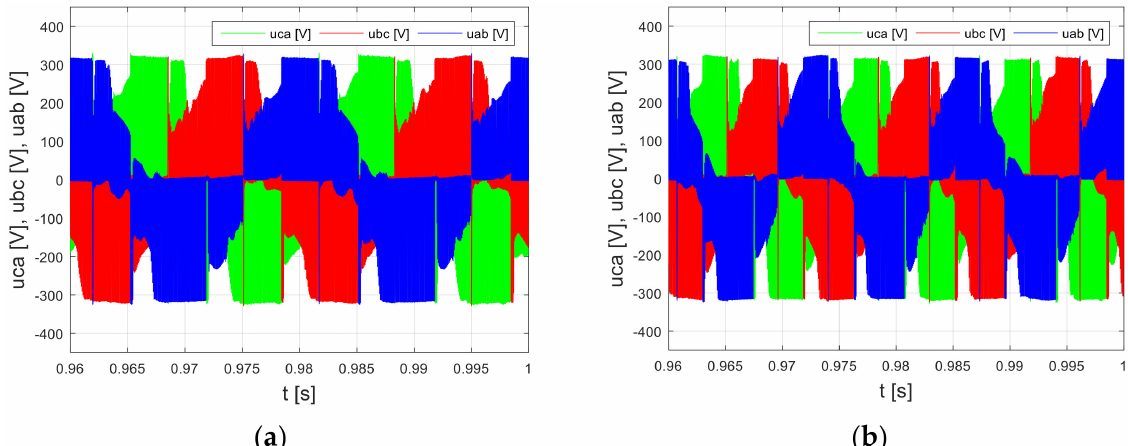
Figure 11. Waveforms of the line-to-line voltages (uab, ubc, uca) at 60 bar pressure for the speed of: ( a ) 1000 rpm; ( b ) 1500 rpm.